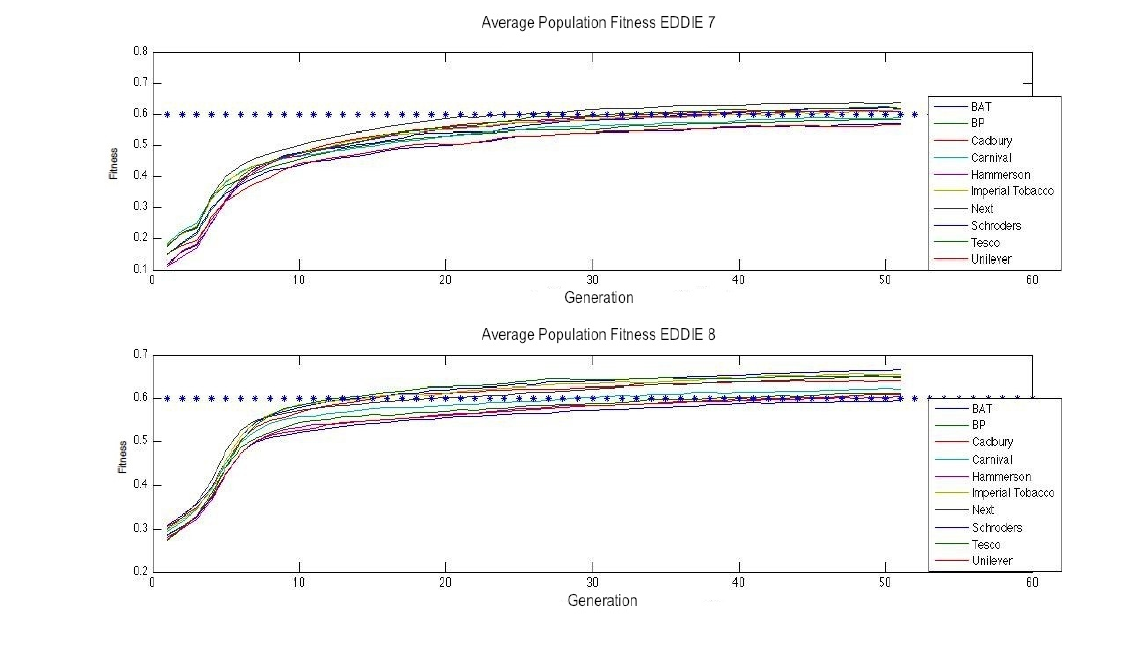
Figure 4 A verage of the average fitness of the population of the GDTs for EDDIE 7 and EDDIE 8. This means that we first obtain the average fitness of the whole population, per generation. Then we find the average of this number over the 50 runs.